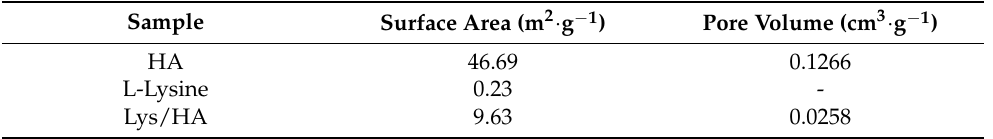
Table 2. Specific surfaces and pore volume of studied